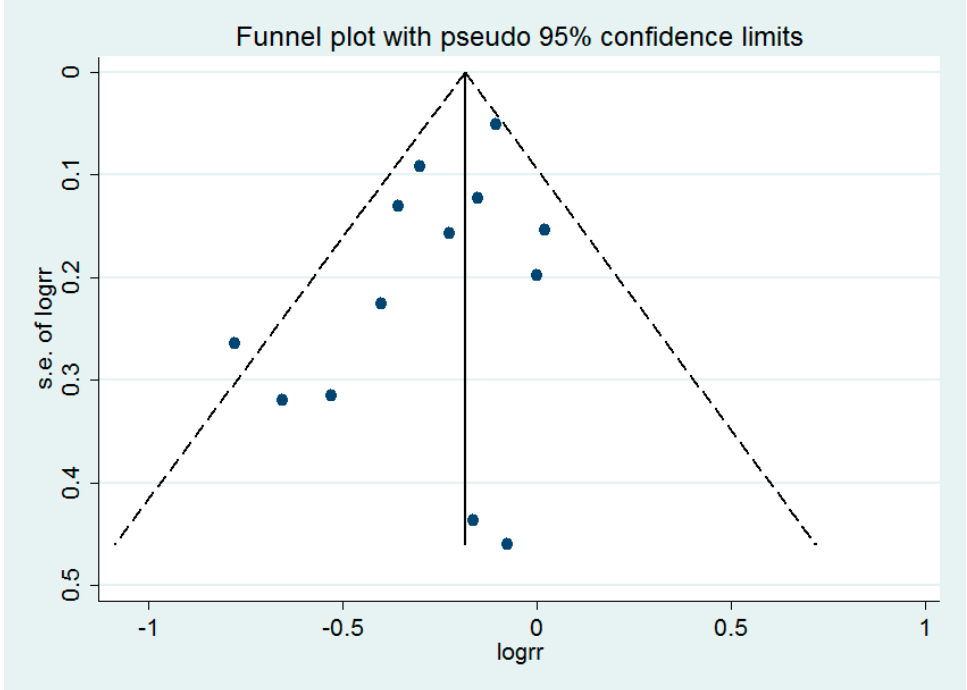
Figure 4. Funnel plot for the analysis of dietary calcium intake and ovarian cancer risk. Each dot represents a different study.